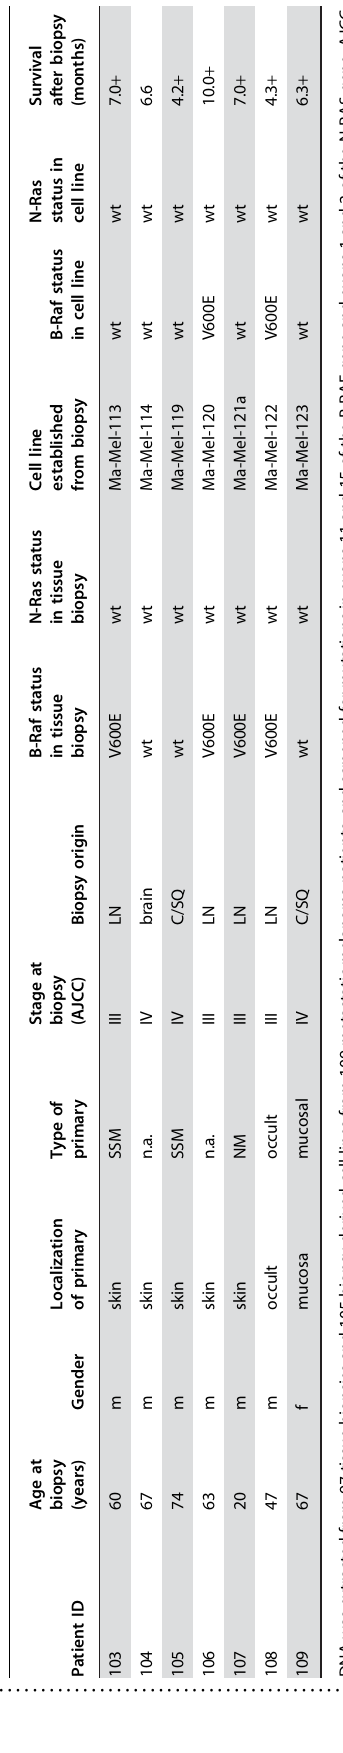
Table 3. Overview on B-RAF and N-RAS mutation status. ... ... ... .... ... ... .... ... ... .... ... ... .... ... ... .... ... ... .... ... ... . Tissues Cell lines 97 (100.0%) 105 (100.0%)